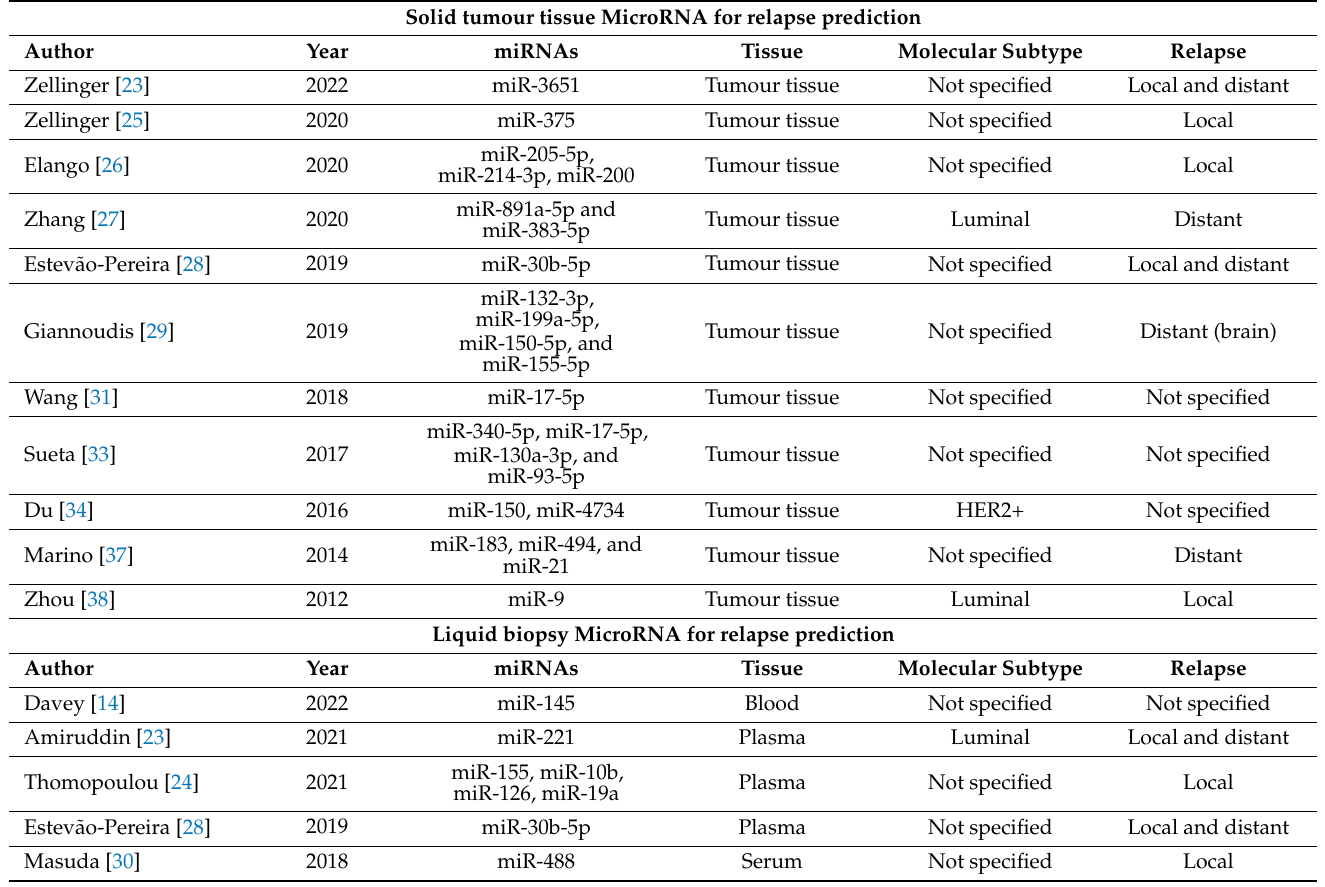
Table 4. MicroRNA relapse patterns in liquid biopsies and tumour